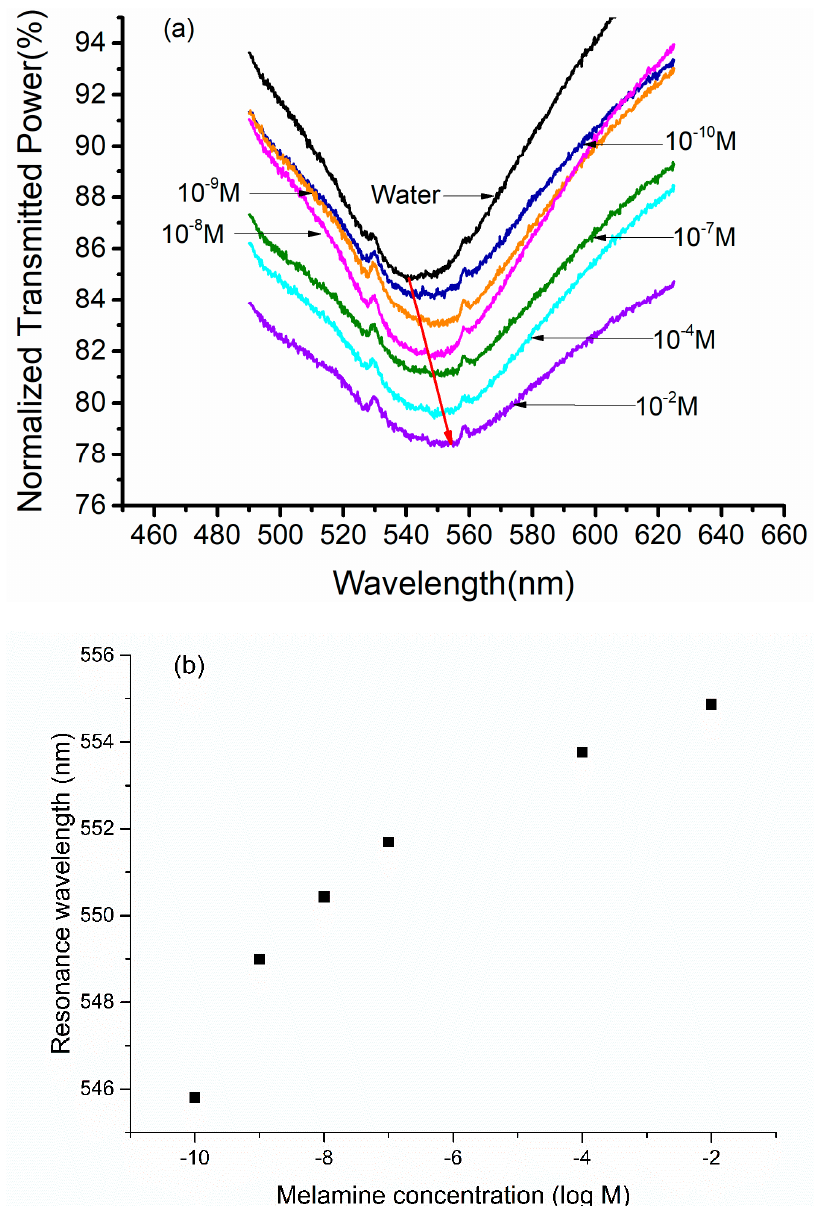
Figure 5. ( a ) SPR spectra for detection of melamine solution with concentration ranging from 0 M to 10 − 2 M; ( b ) shift in resonance wavelength for the detection of melamine solution with concentration ranging from 0 M to 10 − 2